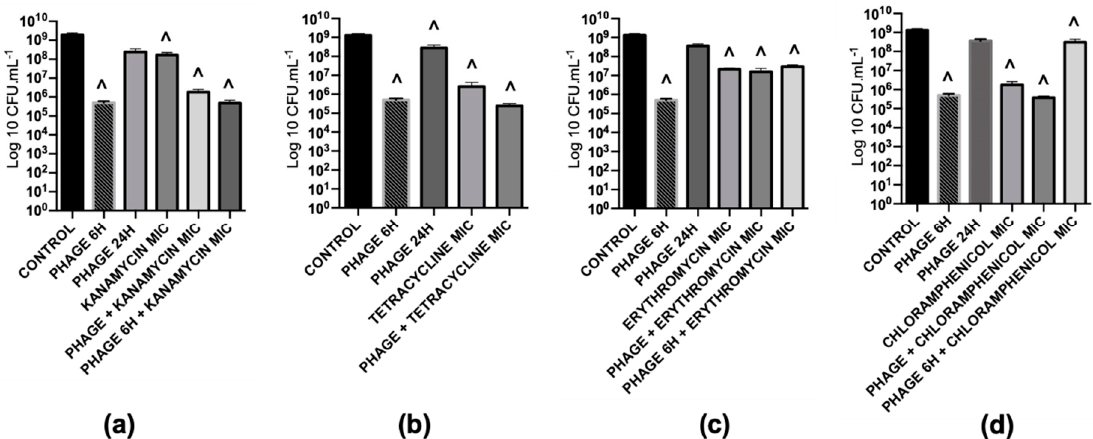
Figure 4. Treatment of P. aeruginosa PAO1 48 h biofilms with protein synthesis inhibitor antimicrobial agents individually or in combinations for 24 h. ( a ) Kanamycin is a 30S protein synthesis inhibitor; ( b )